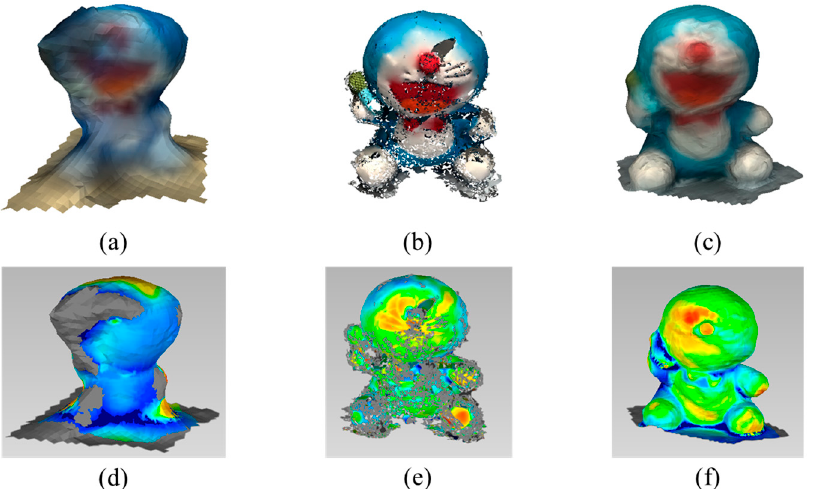
Figure 10. Reconstructed result and error analysis of small object with various methods: Recon- structed result with ( a ) ToF camera; ( b ) stereo camera; ( c ) proposed method; error analysis of ( d ) ToF camera; ( e ) stereo camera; ( f ) proposed method.